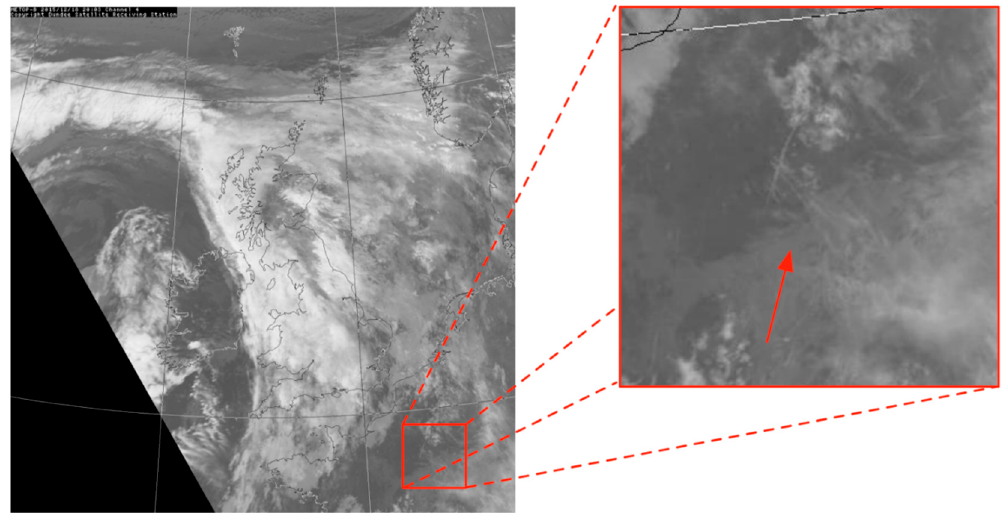
Figure 6. AVHRR (Advanced Very High Resolution Radiometer) Infrared image from Dundee Satellite Receiving Station on 18 December 2015, 20:03 UTC [21] showing the cloud coverage over the UK and Northern France ( left ) with a zoomed view over Northern France ( right ) showing contrail formation (arrow).